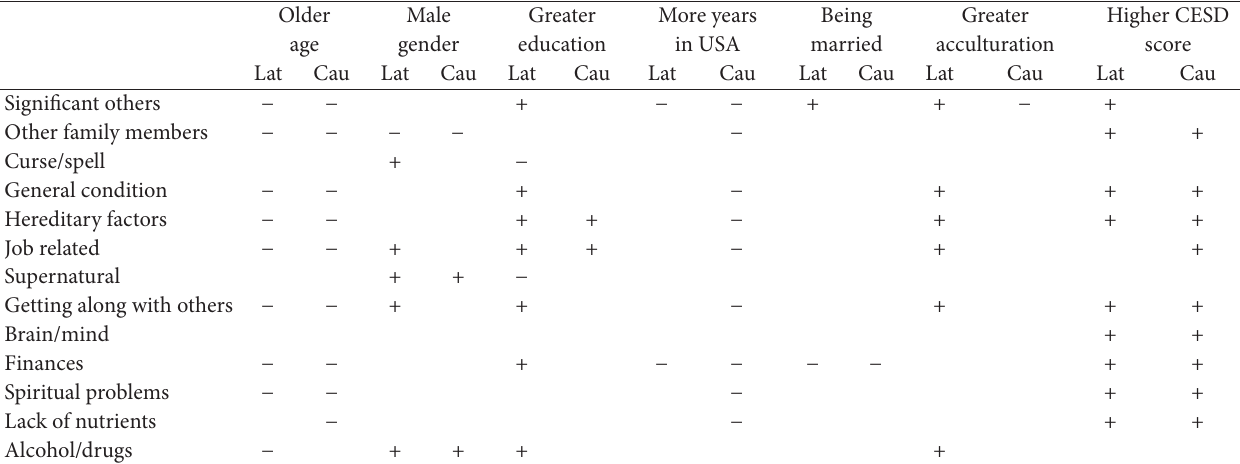
Table 2: Associations between sociodemographic variables, clinical variables, and attribution among